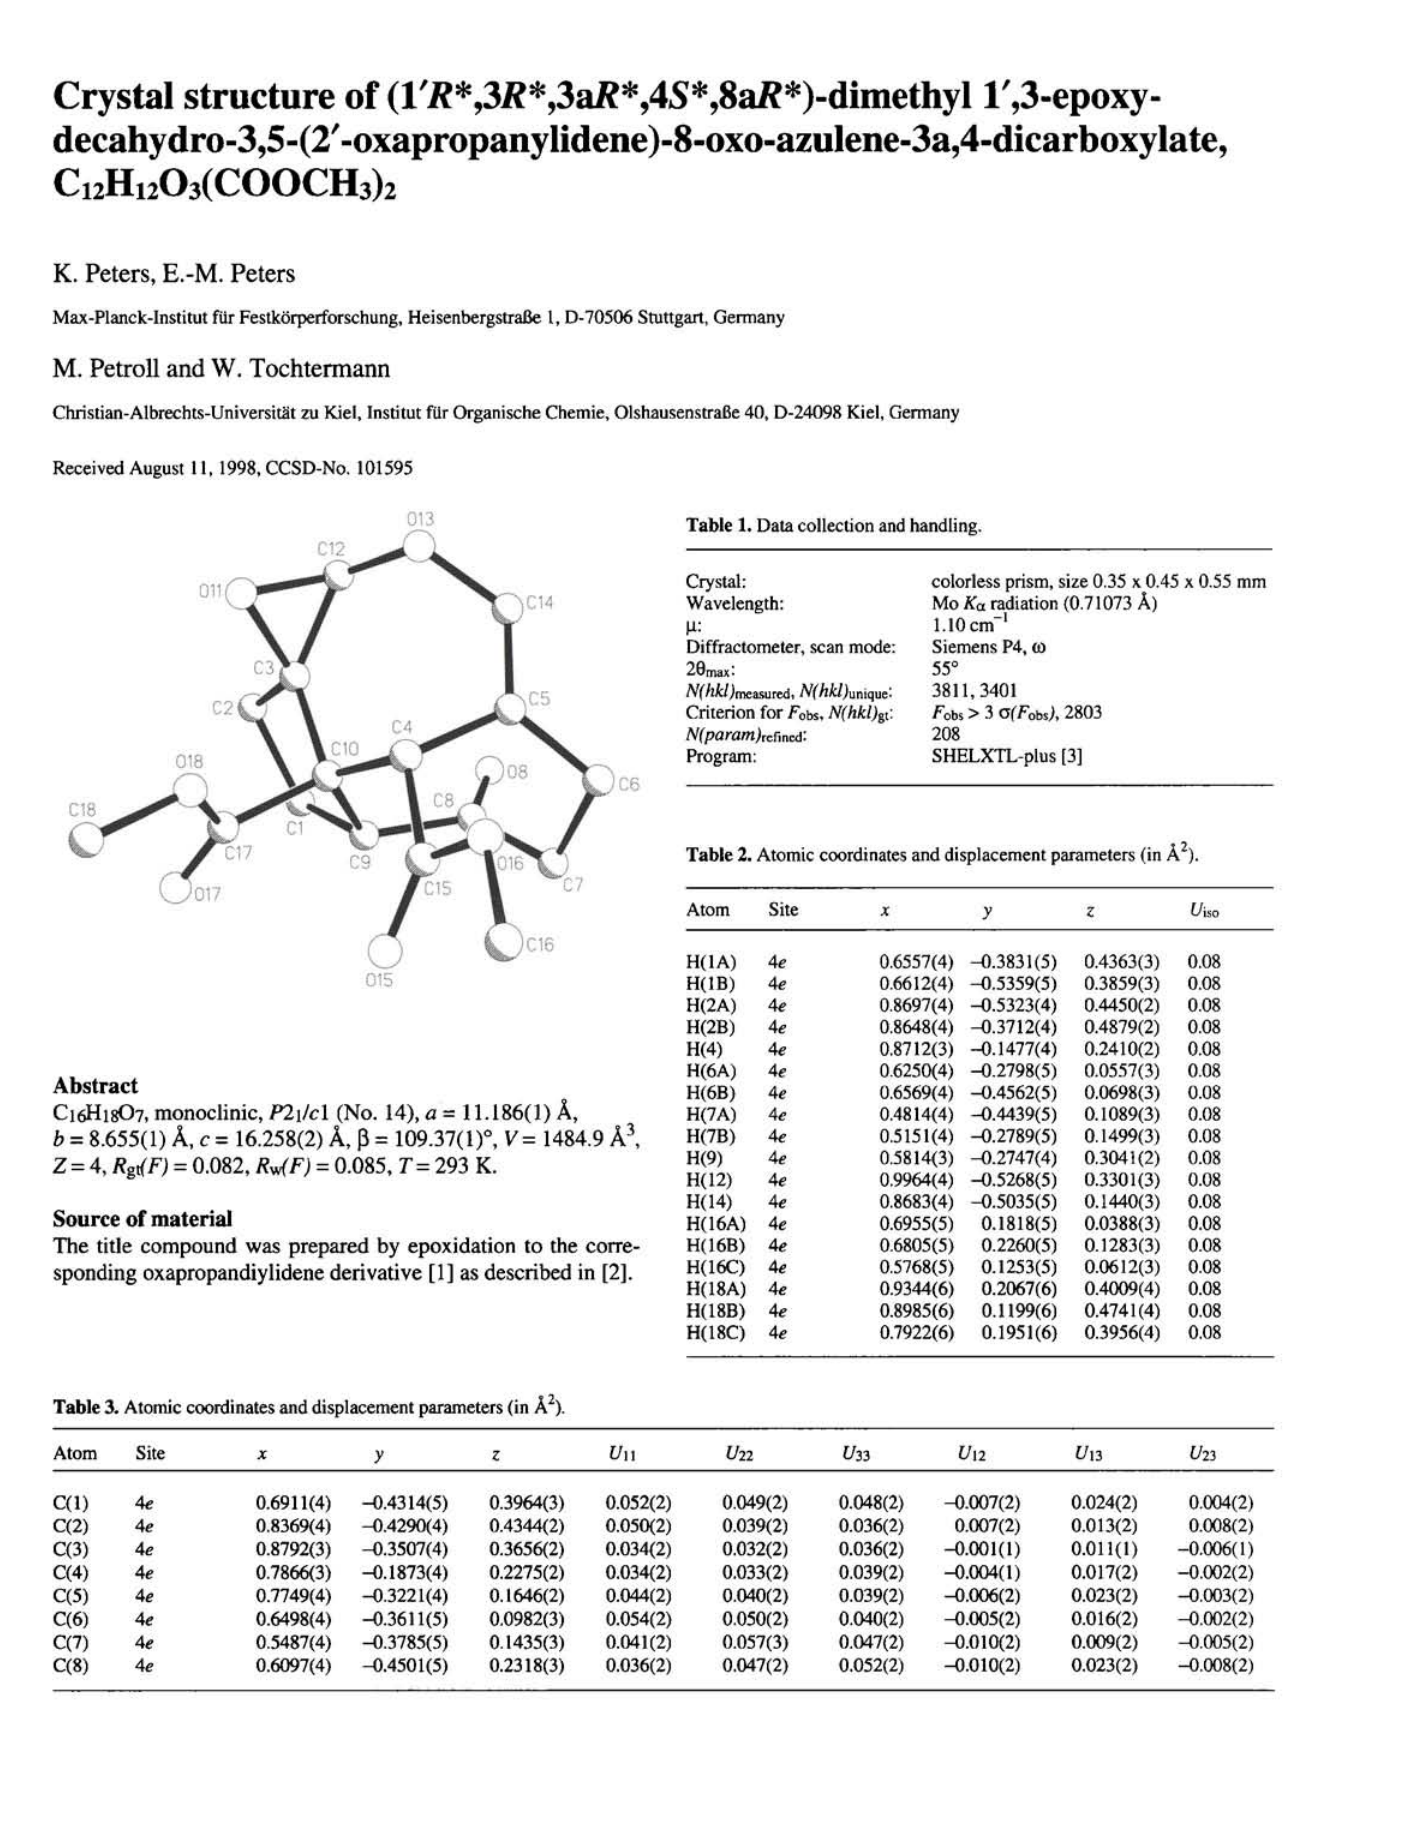
Table 3. Atomic coordinates and displacement parameters (in Â 2 ).